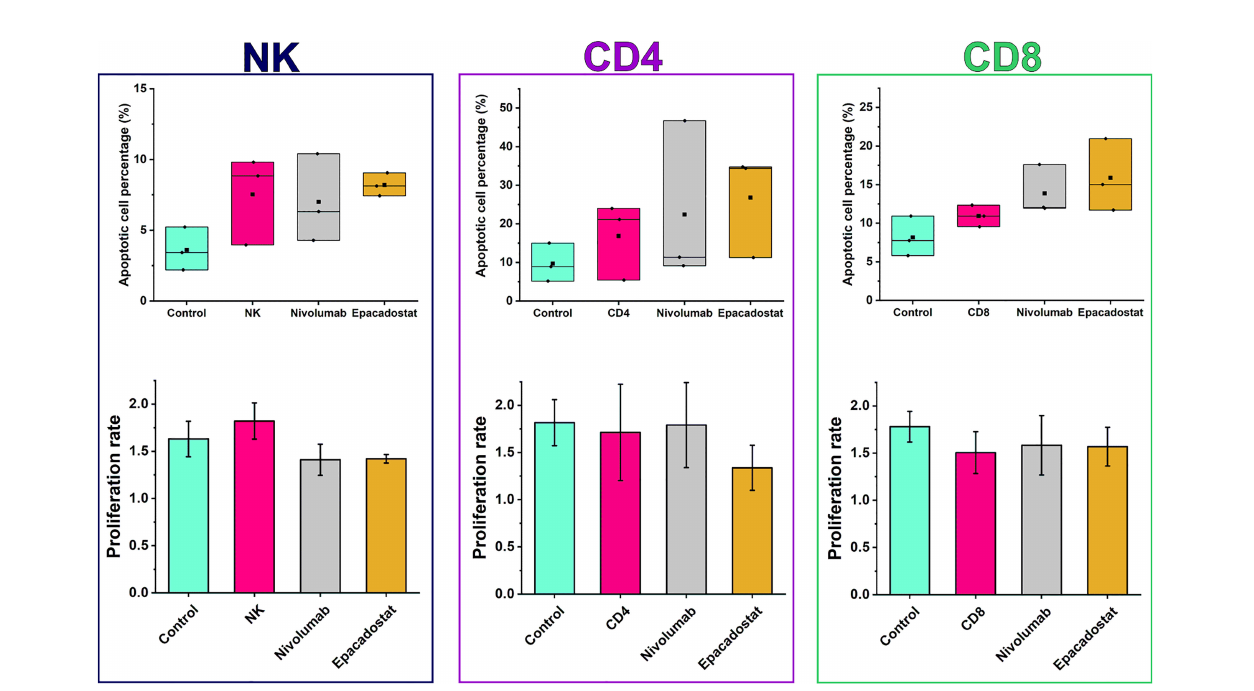
FIGURE 4 | Apoptotic cell percentages and proliferation rates of HSC-3 in the presence or absence of lymphocytes with or without ICIs. There were no signi fi cant differences in apoptotic cell percentage or proliferation between the ICI groups and the lymphocyte or HSC-3 controls. Epacadostat treatment of NK cells exhibited a trend of increased apoptotic percentage and decreased proliferation rate than in the HSC-3 control but not in the NK cell control. Proliferation rates are reported as mean ± SD. The experiments were repeated three times, each time using a different donor and each in duplicate. NK, natural killer cell; CD4, CD4 + T cells; CD8, CD8 + T cells